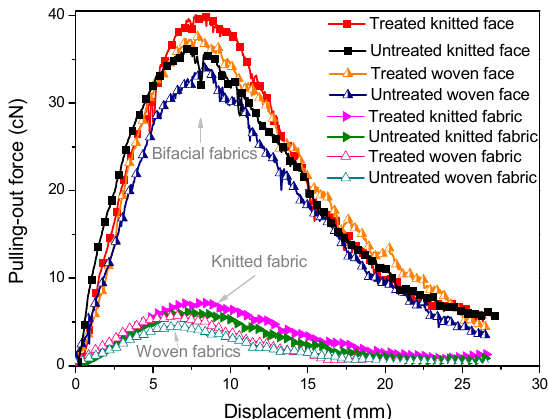
Figure 11. The pulling ‐ out force—displacement curves when the fabrics are bending and sliding on the surface of the bi ‐ U ‐ shaped pins under the pulling action of the pulling pin.